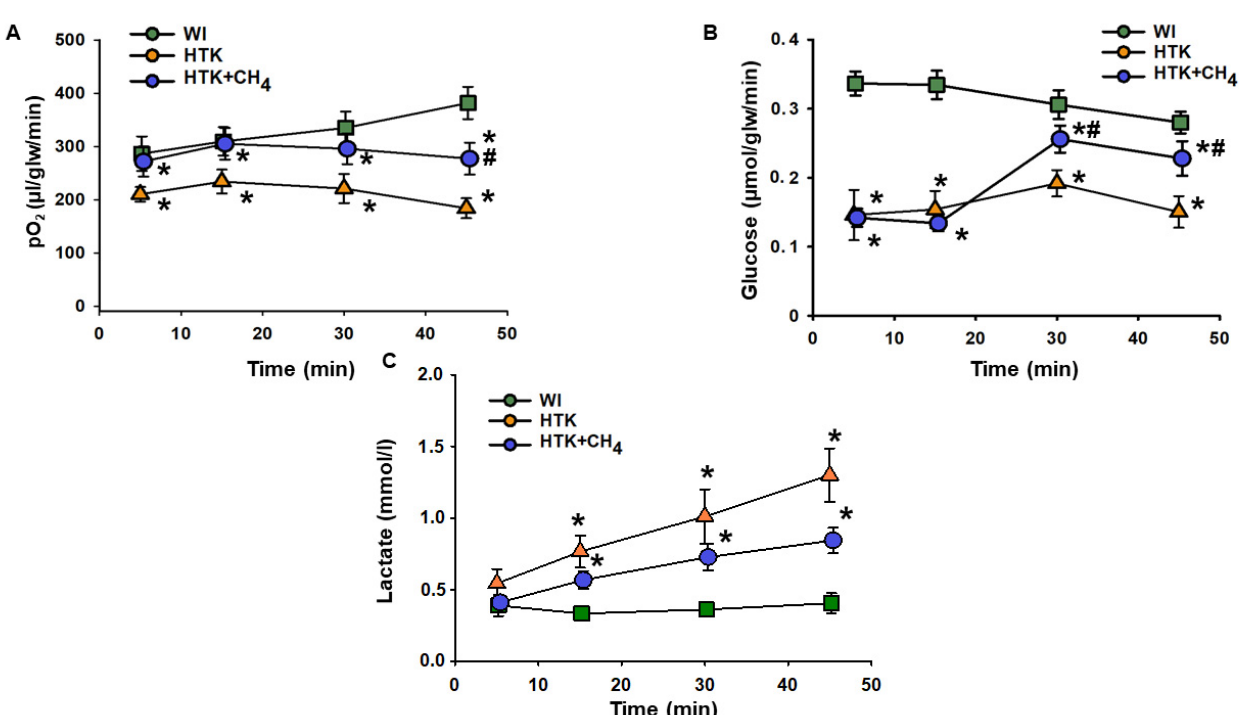
Figure 2. Liver metabolic parameters. ( A ) Oxygen consumption determined as the difference in partial oxygen pressure of influent and effluent Krebs solution. ( B ) Glucose consumption determined as the difference in glucose concentration of influent and effluent Krebs solution. ( C ) Lactate content measured from effluent Krebs solution. The WI group is marked with a green square, the HTK group is marked with a yellow triangle and the HTK + CH 4 group is marked with a blue circle. Data are presented as means ± SD. * p < 0.05 vs. WI; # p < 0.05 vs. HTK (one-way ANOVA and Tukey’s test).